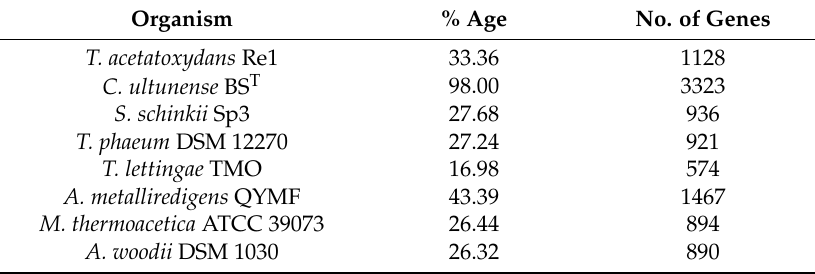
Table 1. Summary of synteny analysis (%) and comparison of inferred proteins (number of genes) of Acetobacterium woodii ) and syntrophic acetate-oxidising bacteria (SAOB) ( S. schinkii , T. acetatoxydans , Th. phaeum , P. lettingae